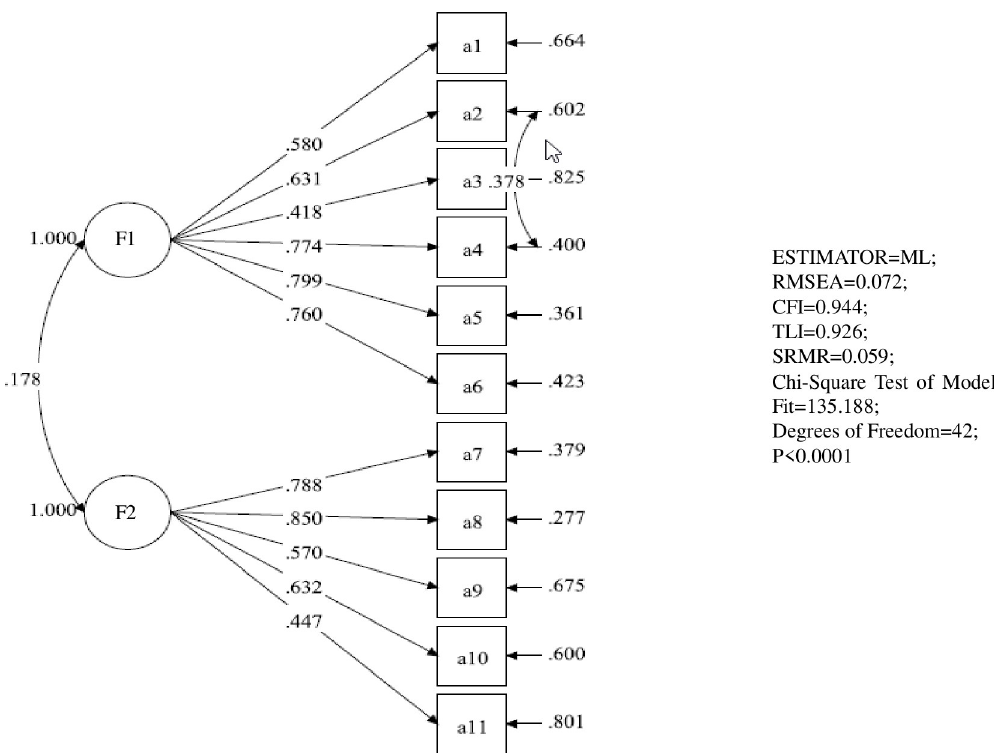
Fig 2. Confirmatory factor analysis of the Chinese version of A-PMC. F1: Care of Residents’ Teeth; F2: Care of Own Teeth.